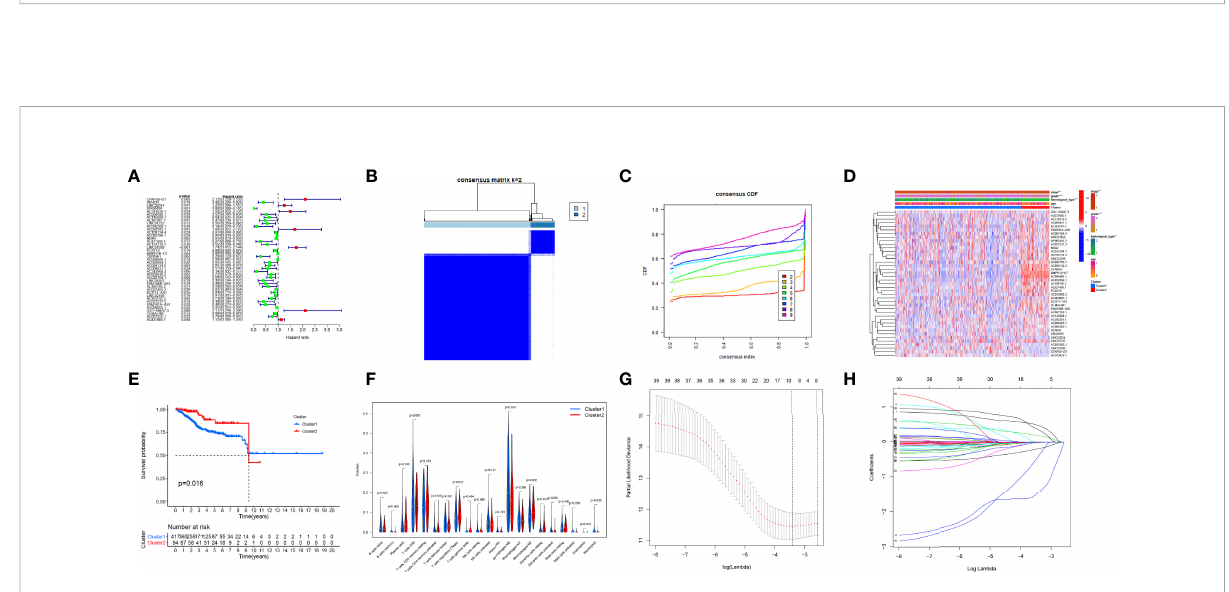
FIGURE 3 Consensus clustering analysis and the construction of the prognostic signature. (A) Univariate Cox regression. (B, C) Endometrial carcinoma (EC) patients of The Cancer Genome Atlas (TCGA) cohort can be classi fi ed into two clusters ef fi ciently. (D) Relationship between clusters and clinical characteristics. (E) Cluster 2 had a more signi fi cant relationship with higher survival probability ( p -value < 0.05). (F) The levels of immune cell in fi ltration between the two clusters were different. (G, H) Least absolute shrinkage and selection operator (LASSO)